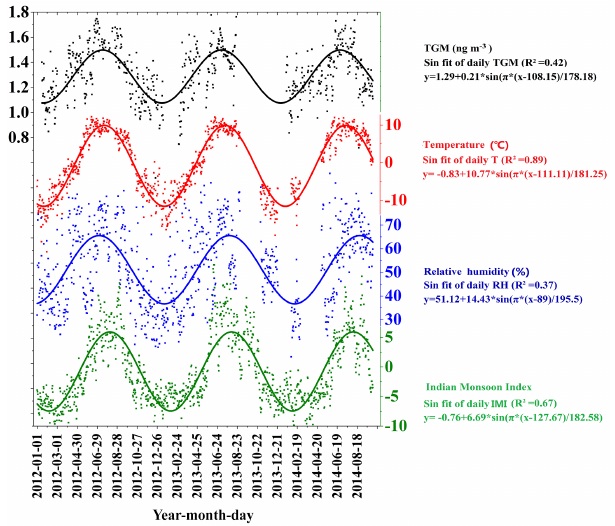
Figure 12. Series of daily mean TGM, temperature, relative humid- ity and Indian monsoon index and their sinusoidal curve